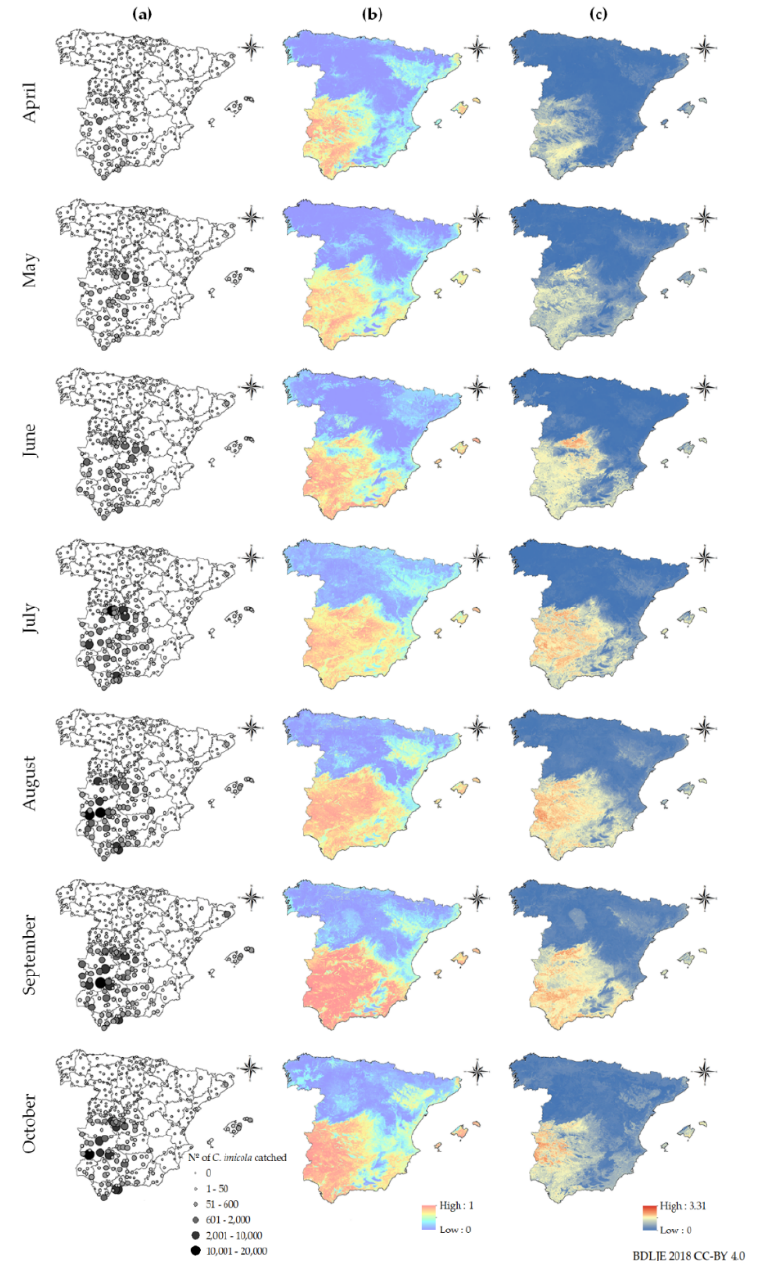
Figure 2. Monthly C. imicola ’s: ( a ) abundance in sampling sites, ( b ) occurrence model, ( c ) abundance model. Administrative boundaries provided by Instituto Geográfico Nacional (ign.es); BDDAE CC-BY 4.0.